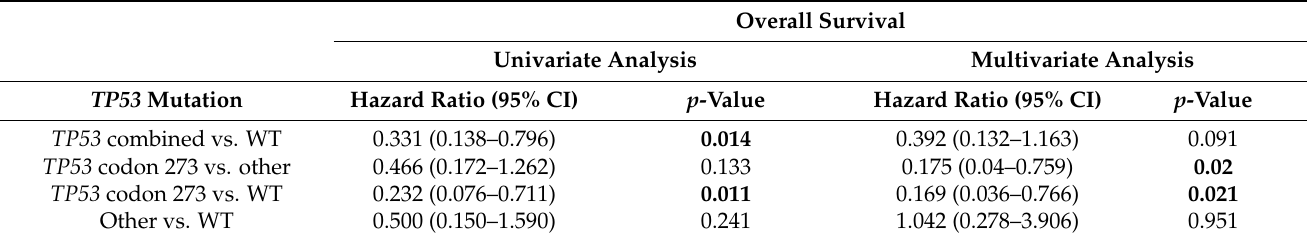
Figure 2. Kaplan–Meier survival curves for grades II and III astrocytoma in our cohort and the TCGA astrocytoma dataset based on TP53 mutation status. ( A ) Overall survival and ( B ) progression-free survival curves for our astrocytoma cohort. ( C ) Overall survival and ( D ) progression-free survival curves for the TCGA astrocytoma cohort. WT: wild-type, MUT: TP53 mutant. Log-rank test was used for analysis and a p -value < 0.05 for statistical significance. Table 4. Univariate and multivariate survival analyses of astrocytoma in this study.